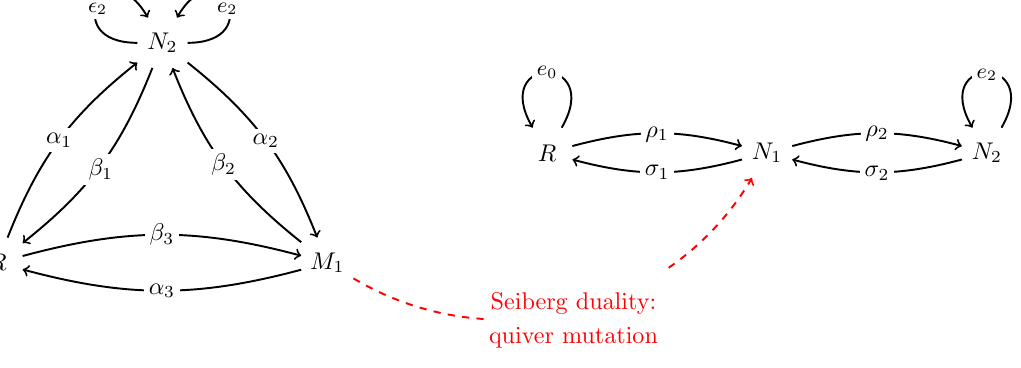
Figure 11. The NCCR of R = C [ x; y; z; t ] = (B.6) before and after Seiberg duality (i.e. categorical quiver mutation [82]) performed at node M 1 . The M i are rank-one CMs (and correspond to physical SU( N ) groups), whereas the N i are rank-two (and correspond to SU(2 N